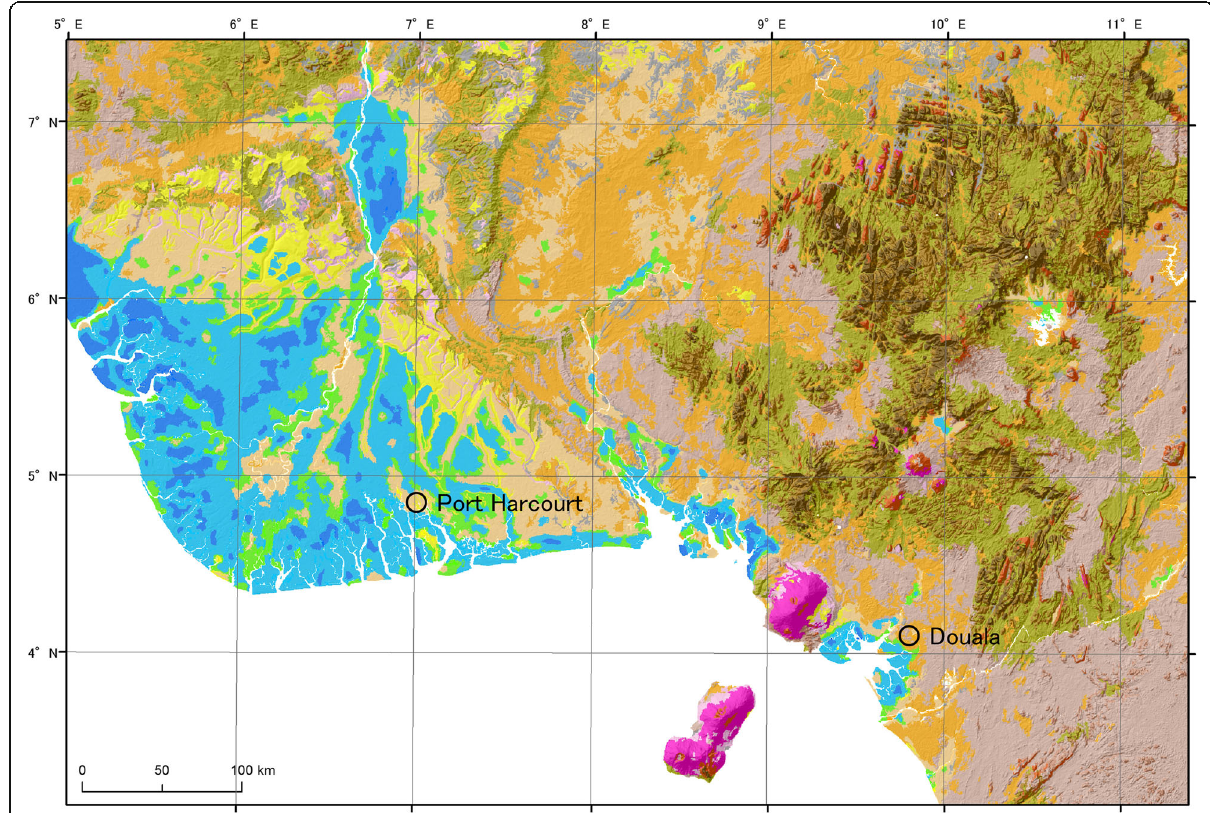
Fig. 18 Shaded terrain classification image of the Cameroon line and Niger